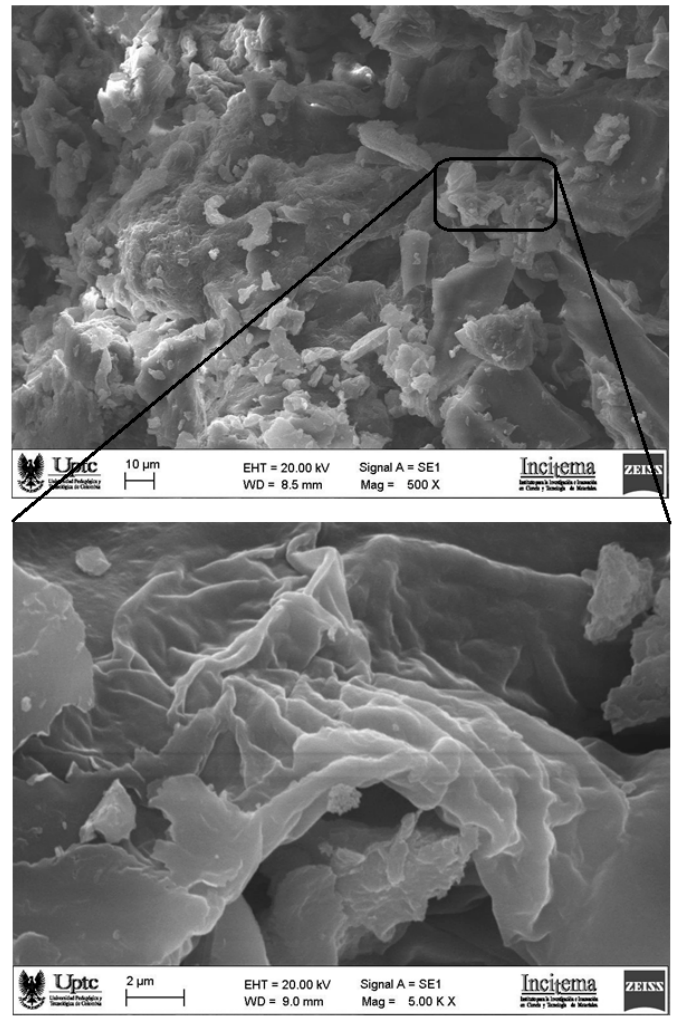
Figure 6. SEM micrograph images of the surface at 500 × ( top ) and 5000 × ( bottom ) of powdered mucilage extracted from Opuntia ficus-indica fruit peel.